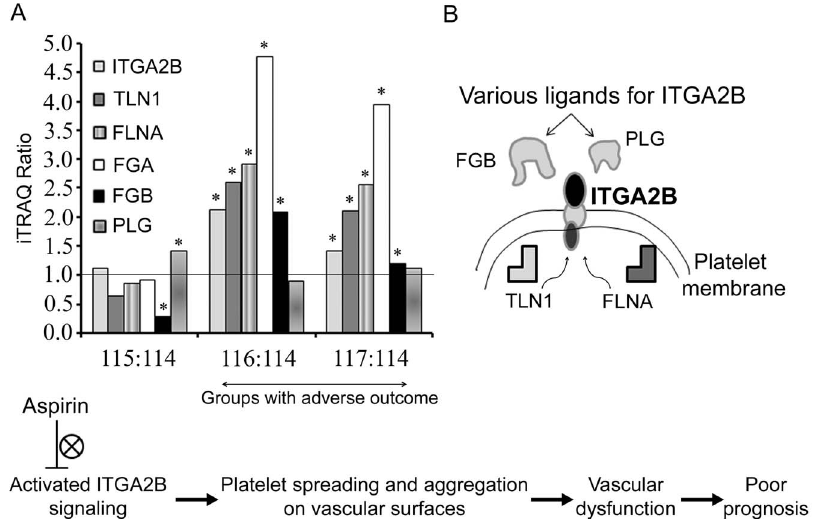
Figure 4. A) Histogram showing the iTRAQ ratios of selected proteins related to focal adhesion (ITGA2B, TLN1 and FLNA) and coagulation cascade (FGA, FGB and PLG). Demographically matched control group was used as the common denominator (i.e. 114) for comparing the three groups of LACI patients. The solid line indicates no change in regulation. The LACI groups with adverse outcome (recurrent vascular event, 116; cognitive decline, 117) had a differential signature in comparison with the LACI group with no adverse outcome (i.e. 115). Up- regulation of proteins related to focal adhesion and coagulation (FGA, FGB) at the baseline is predictive of poor outcome. *Denotes ratios with significant p -value ( , 0.05). B) Schematic diagram showing the interaction of various ligands of ITGA2B on platelet membrane and the probable involvement down-stream intracellular proteins (e.g. TLN1 and FLNA) in vascular dysfunction that may be responsible for poor prognosis. Aspirin partially blocks the integrin signaling as seen in the